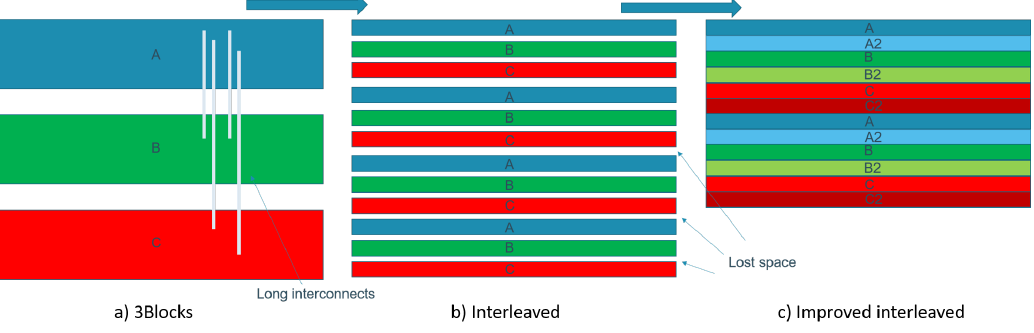
Figure 2. Different placement methods. ( a ) 3Blocks ( b ) Interleaved ( c ) Improved